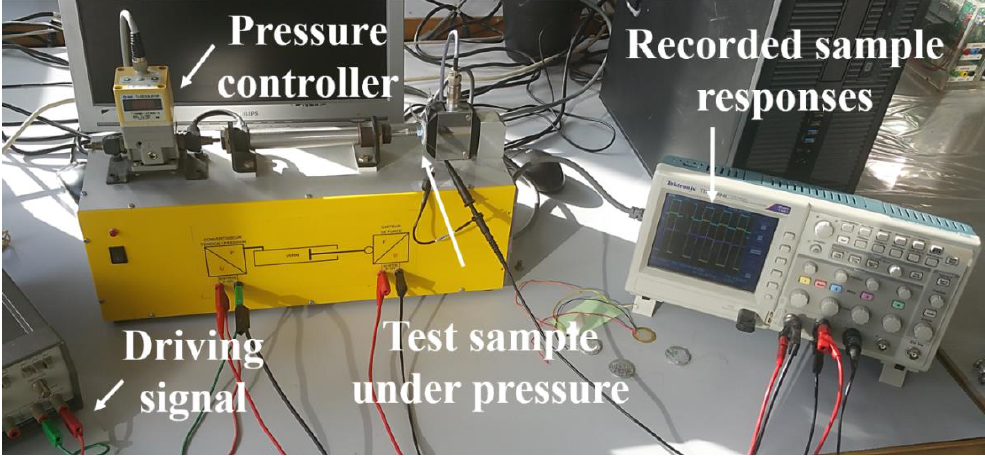
Figure 8. Dedicated direct piezoelectric coefficients measurement setup.